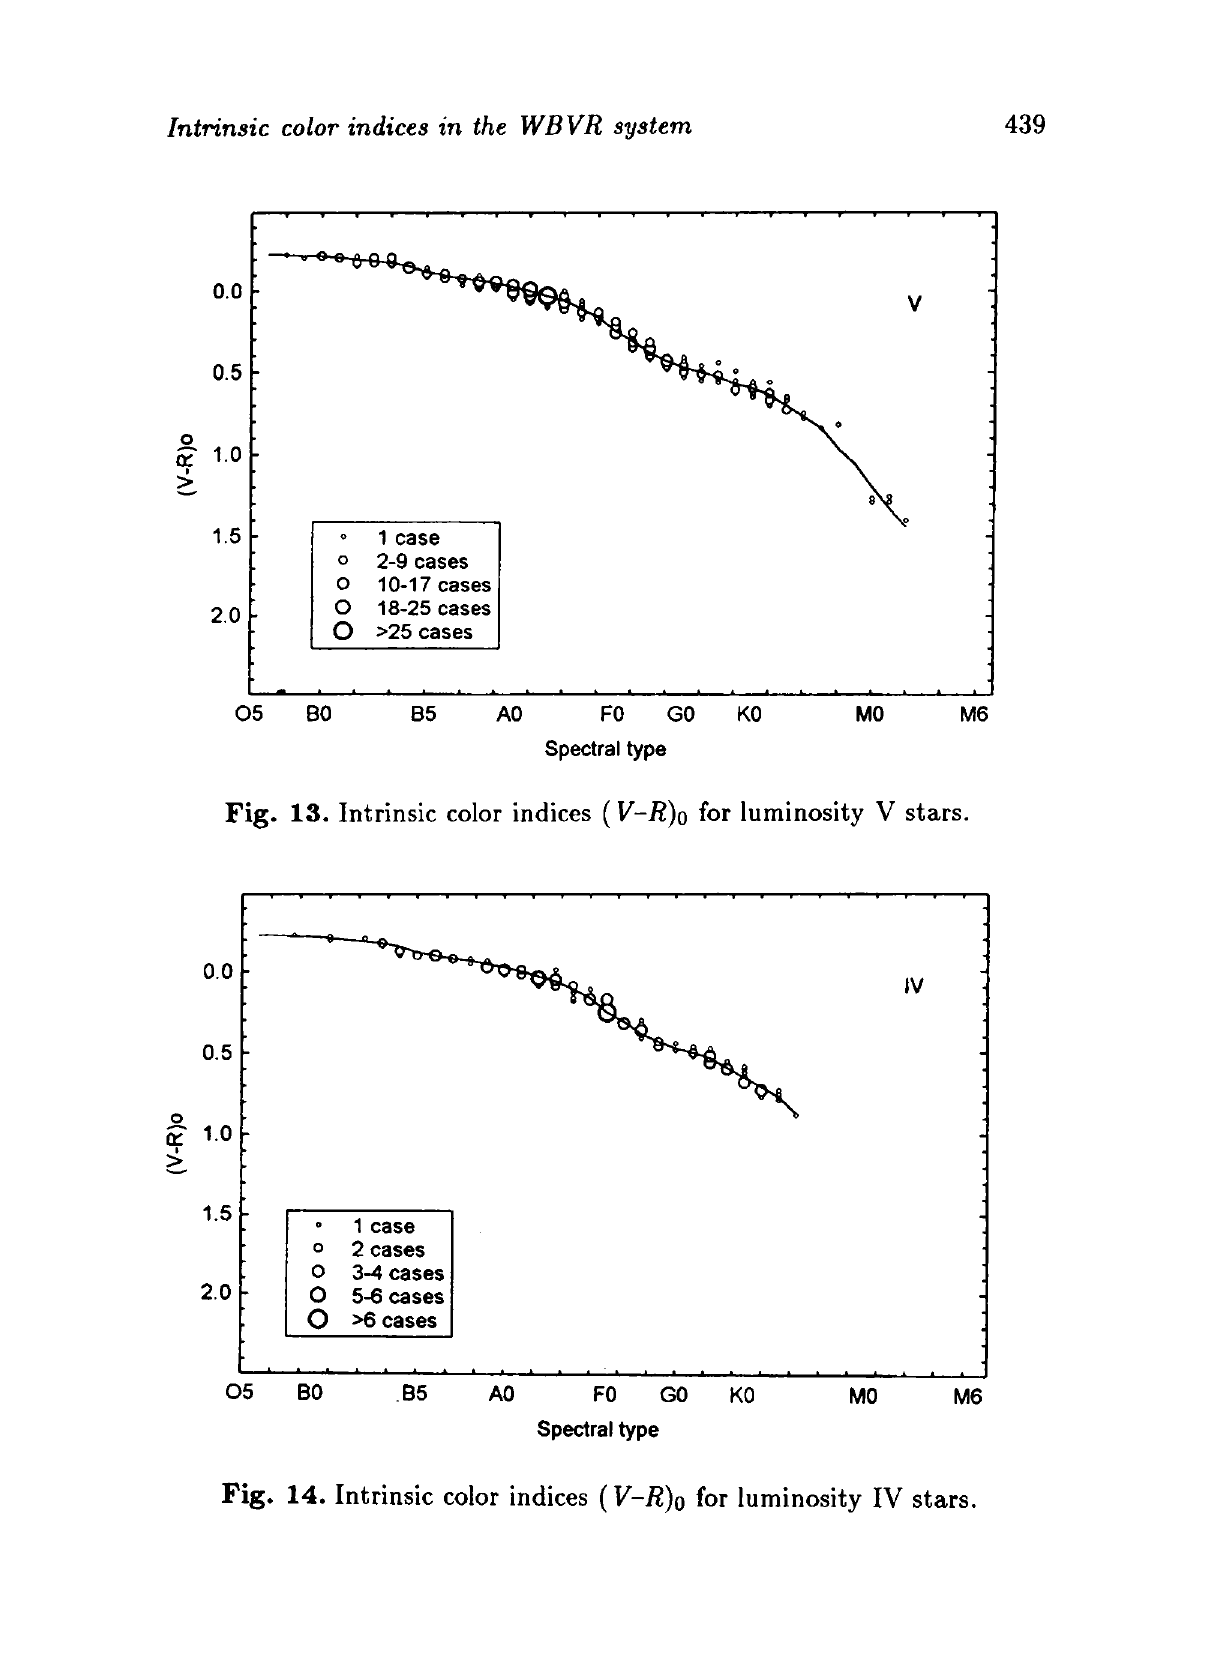
Fig. 14. Intrinsic color indices ( V-R) o for luminosity IV